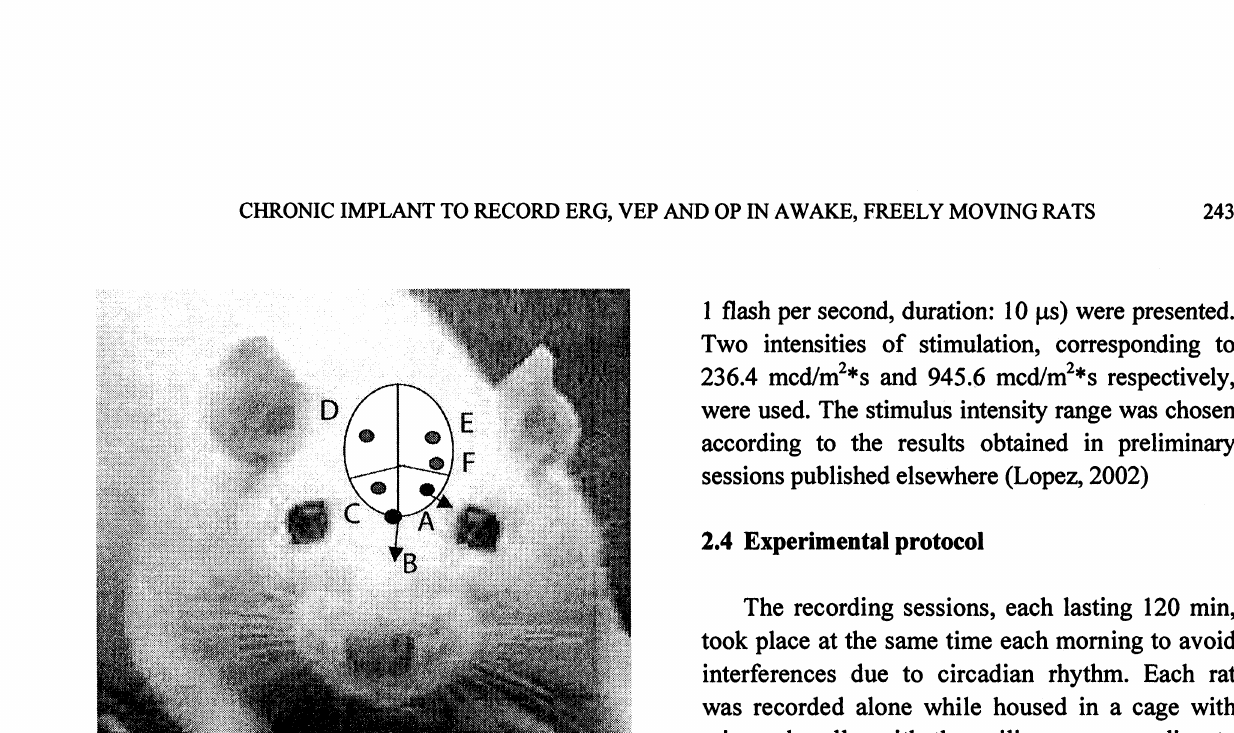
Fig. 1 A. ERG active electrode; B. ERG reference electrode; C. (D+) cortical electrode; D.